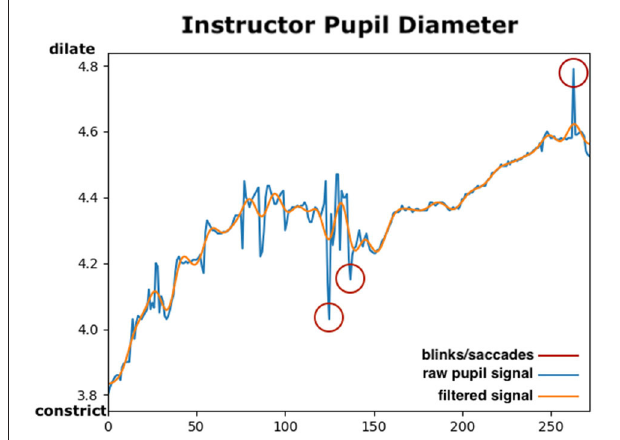
FIGURE 4 | The mean pupil diameter in a segment of Instructor 3. The window represents changes in pupil diameter size in about 5 s between two utterances. The blue line depicts the raw sensory data, and the orange line shows the filtered signal using a low-pass filter. Potential eye-blinks/saccades are shown in red circles and how the filter adjusts the resulted pupil signal. X -axis indicates the pupil diameter size in mm and y -axis indicates time in frames (50 Hz). This figure is best viewed in